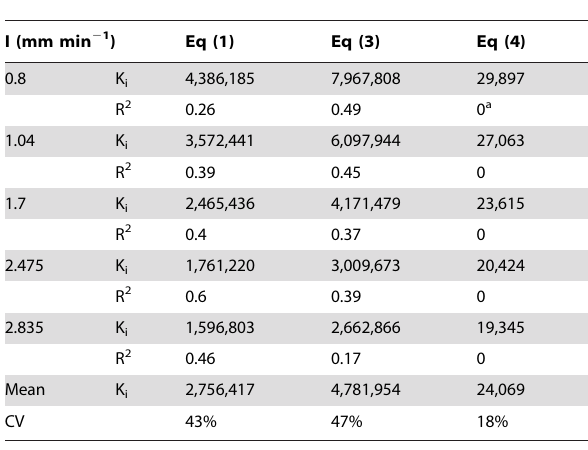
Table 2. Interrill erodibilities ( K i ) and coefficients of determination ( R 2 ) for Eqs. (1), (3), and (4) for different rainfall intensities.